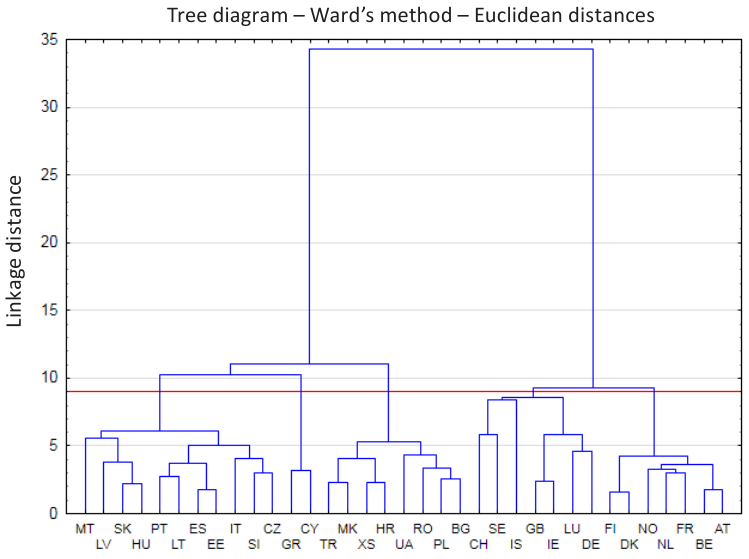
Figure 5. Countries grouping